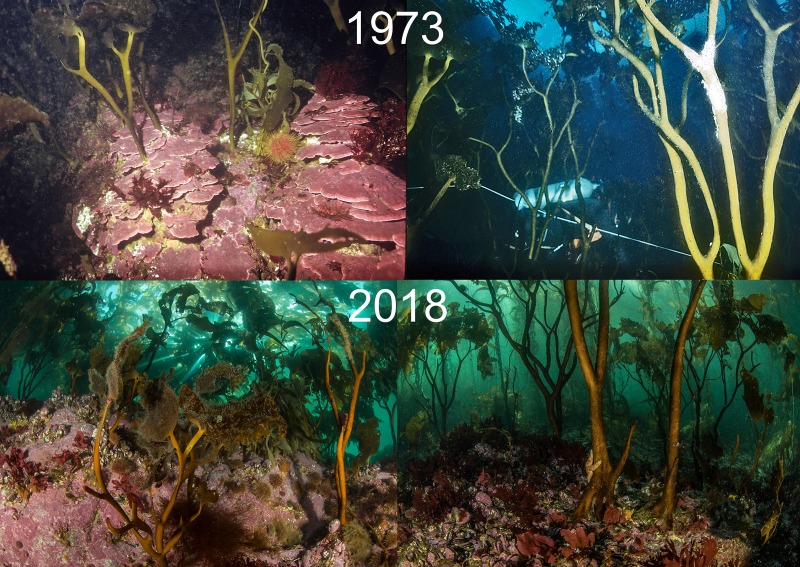
Lessonia vadosa at Isla de los Estados, 1973 and 2018.